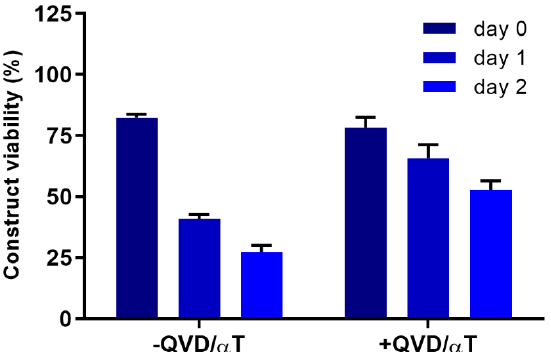
Figure 4. Construct viability after vitrification and recovery with and without additives. Constructs were vitrified in VS70 using our modified protocol. Constructs were incubated overnight in media with and with out 100 μM α - tocopherol (αT) and 25 μM Q -VD-OPH (QVD), then vitrified in VS70. Upon rewarming, the constructs were incubated in media with or without QVD and αT for 2 days post-rewarming. Viability was measured using the resazurin assay and is the mean (±SEM) of >16 replicates. Statistical analysis performed by one-way ANOVA and Tukey’s multiple comparison test.